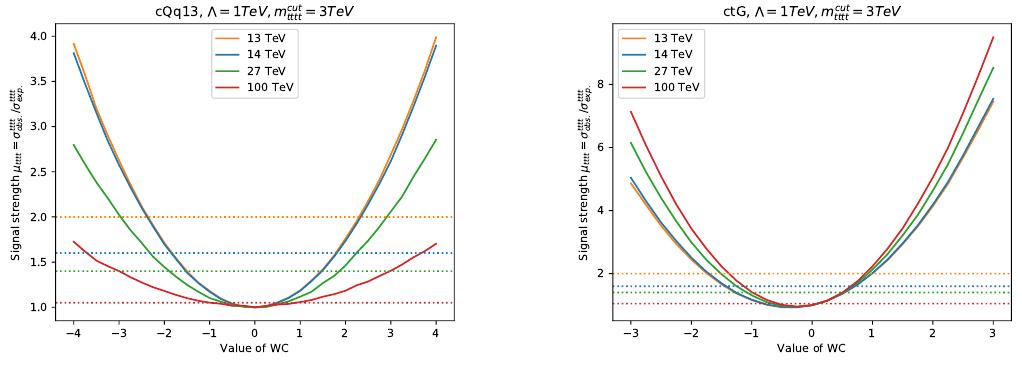
Figure 16 . Same as figure 15 but for the O 3 , 1